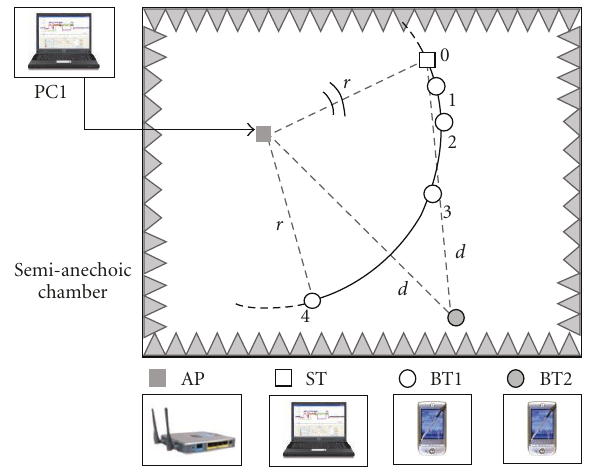
Figure 1: First measurement scenario: adopted